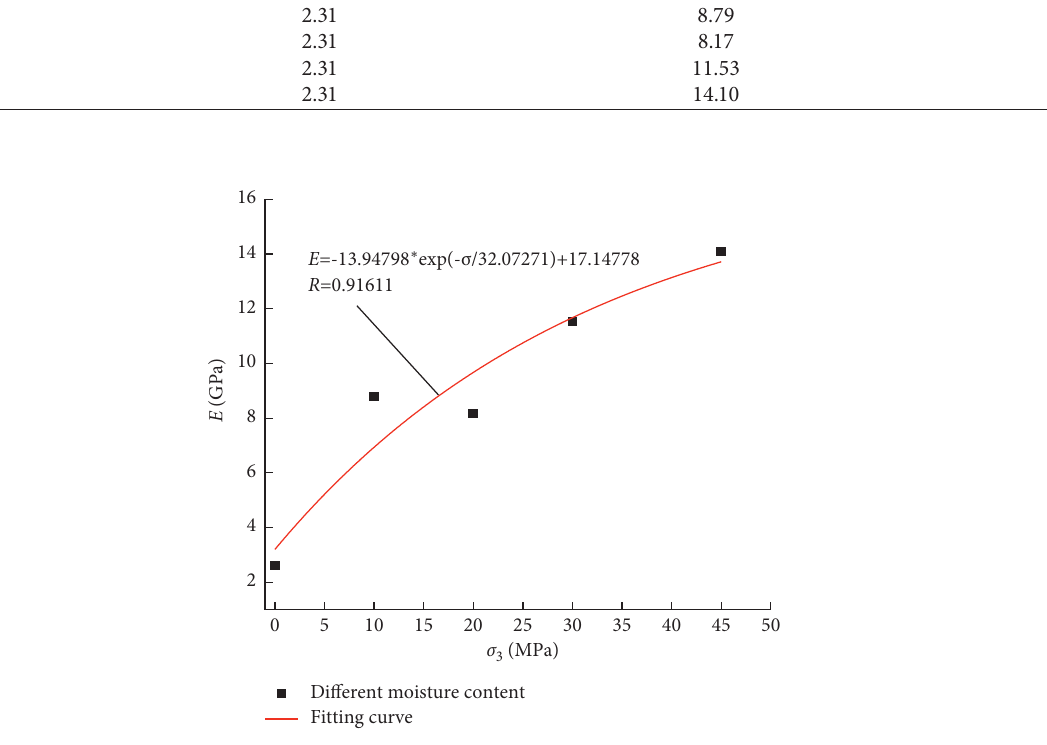
Figure 7: The change trend of the elastic modulus and the confining pressures with the water content of